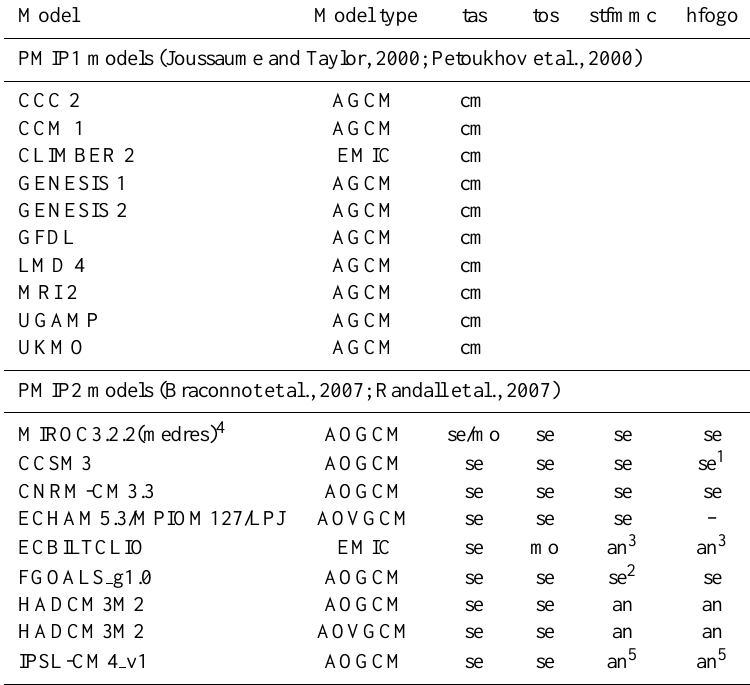
Table 1. Variables available for PMIP1 and PMIP2. 2-D model output: “tas”, 2m surface air temperature, “tos”, SST. Zon- ally averaged regional output: “stfmmc”, overturning steam function; “hfogo”, northward heat transport. There are 4 regions (global, pacific, indian and atlantic) for the PMIP2 models, apart from CCSM, which has only 2 (global-marginal seas and at- lantic+mediterranean+labrador+GIN+Arctic). Temporal resolution: “cm”, monthly mean output from PMIP1;“‘mo”, daily data for 100yr; “‘se”, monthly mean output for 12 months averaged over 100yr; “an”, 100 (or 99 for HADCM3 AOVGCM) years of annual av- erage